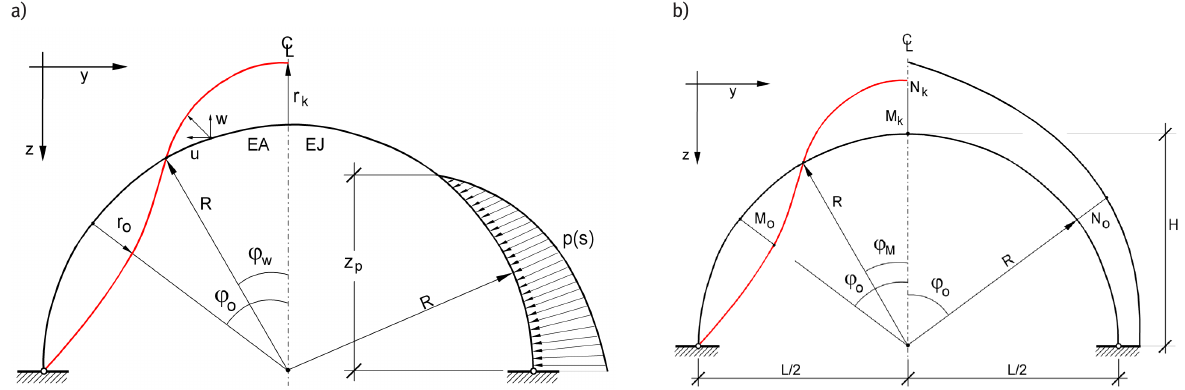
Figure 2: Scheme of the soil interaction with internal forces due to the deformation of the circumferential band of the shell.